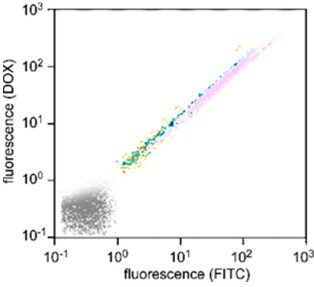
Figure 3. Time dependence of cellular uptake of DOX-loaded SS-bonded nanocapsules that were covalently labeled with fluorescein isothiocyanate (FITC). Control (without treatment): gray points; 1 h: yellow points; 2 h: green points; 4 h: blue points; 8 h: pink points.